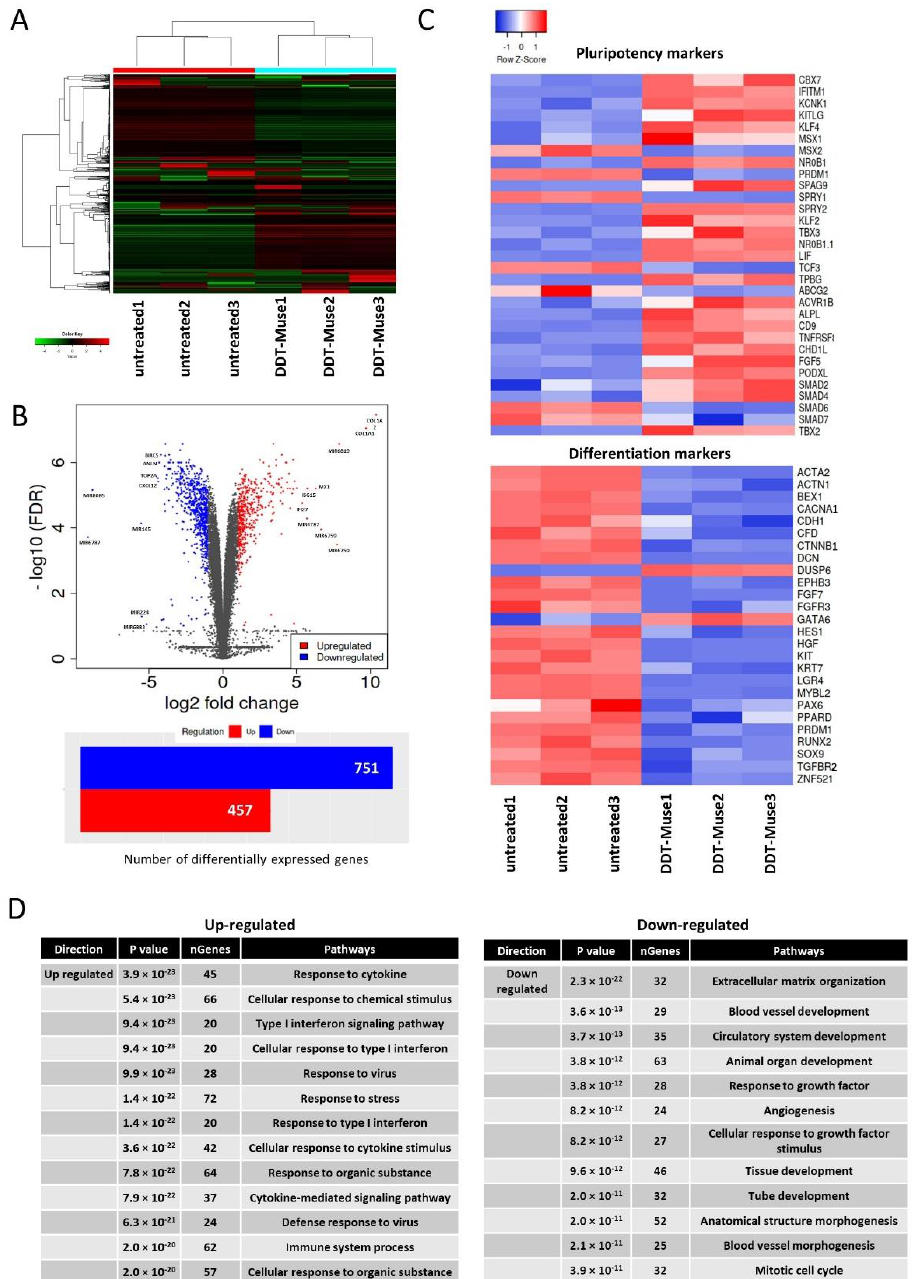
Figure 5. RNA-seq of DDT-treated Muse cells. ( A ) Dendrogram and unsupervised hierarchical clustering heat map of untreated-(1, 2, 3) and DDT-treated (1, 2, 3)-Muse cells. The degree of similarity between gene expression profiles is represented by the vertical distances on the dendrogram. The highest degree of correlation is represented by short vertical distances; ( B ) Volcano plot showing differentially expressed genes between untreated- and DDT-treated-Muse cells. Genes are plotted according to their p -value (y-axis), and their expression in DDT-treated cells relative to untreated cells (x-axis) is demonstrated. The number of differentially expressed genes is also shown (Blue: genes down-regulated in DDT-treated Muse cells relative to untreated Muse cells; red: genes up-regulated in DDT-Muse cells relative to untreated Muse cells); ( C ) Heatmaps of genes, relevant to pluripotency and differentiation differentially expressed between untreated-(1, 2, 3) and DDT-treated (1, 2, 3)-Muse cells are shown; ( D ) The list of up-regulated and down-regulated pathways in Muse cells after DDT